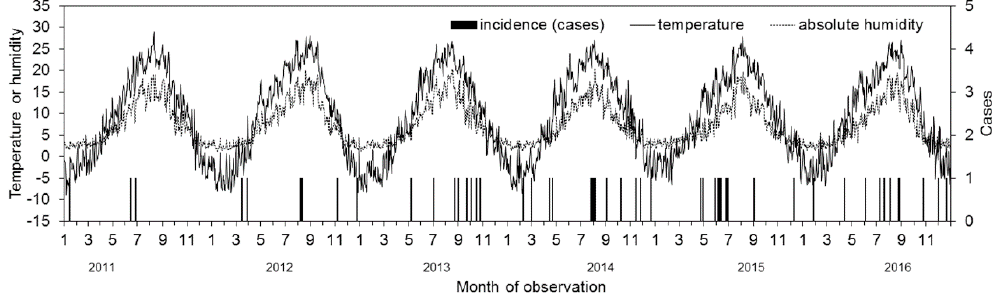
Figure 1. Comparison between climatological variables and frequency of blood culture positives with Bacillus spp. from 2011–2016. Daily average temperature and absolute humidity (g/m 3 ) in Sapporo city were retrieved from a local weather station. Incidence of positive blood culture with Bacillus spp. are measured on the right vertical axis. Date of incidence on the horizontal axis is measured by the date of sample collection.